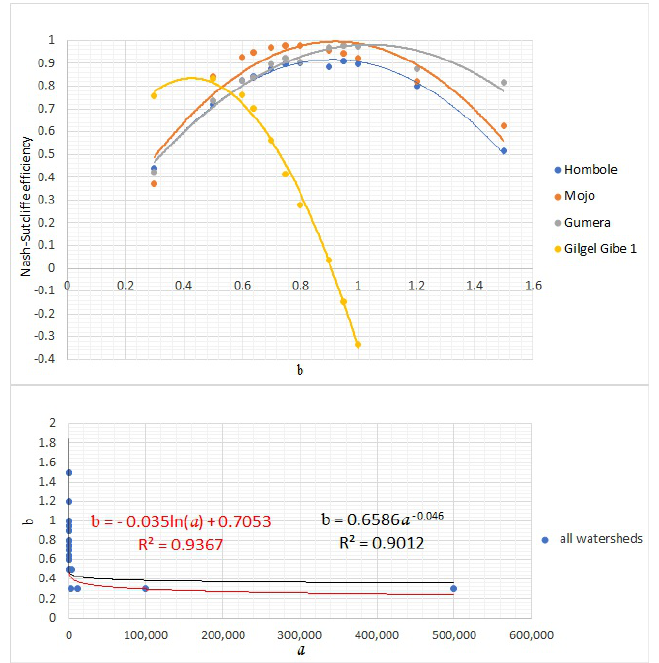
Figure 21. Therelationship between exponent b versus the Nash–Sutcliffe efficiency and the coefficient a versus the exponent b when the topographic factor is calculated using the equation that was proposed by [7].